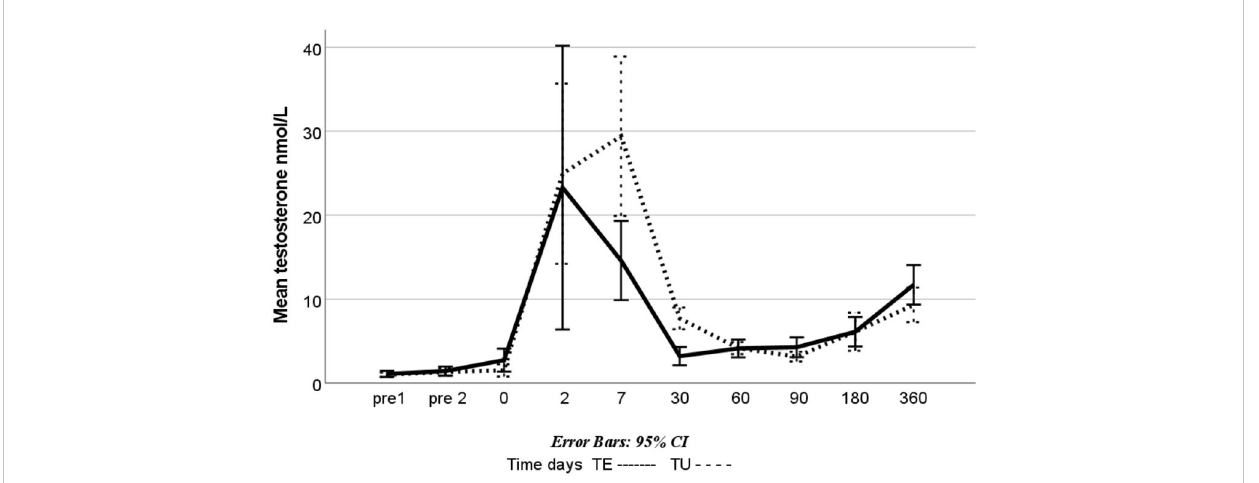
FIGURE 2 Mean testosterone levels in the Pubertal Replacement in Boys Study: boys treated with Testoviron Depot ® (TE) and Nebido ® (TU); blood levels of testosterone (nmol/L) were measured between 07:30 and 09:00 a.m. twice before the study start, at the start (0 d), after 2 and 7 days (2 d and 7 d), and after 1, 2, 3, 6, and 12 months (1 m, 2 m,